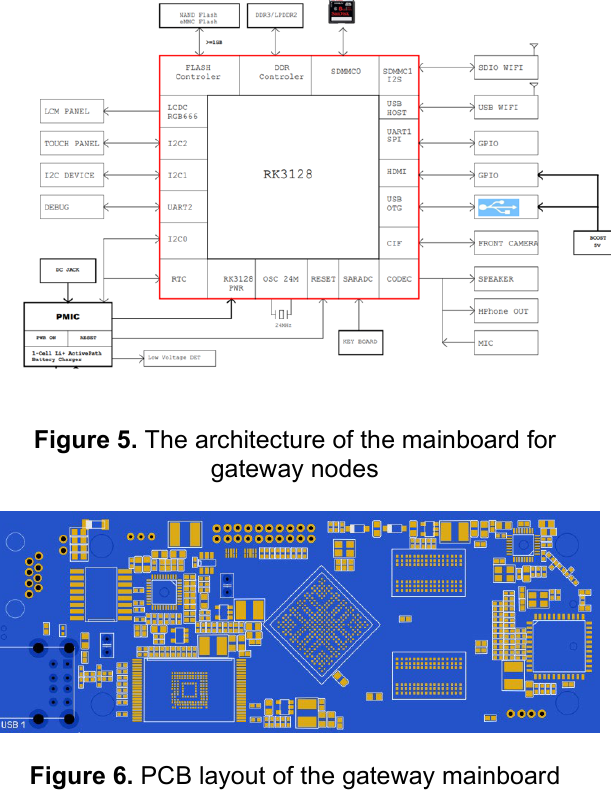
Figure 6. PCB layout of the gateway mainboard